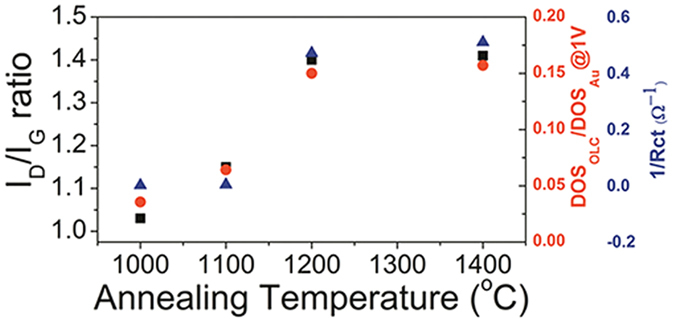
The annealing-temperature dependences of the ID/IG ratio, DOS, and Rct−1 corresponding to Figs S14, S15 and S18.